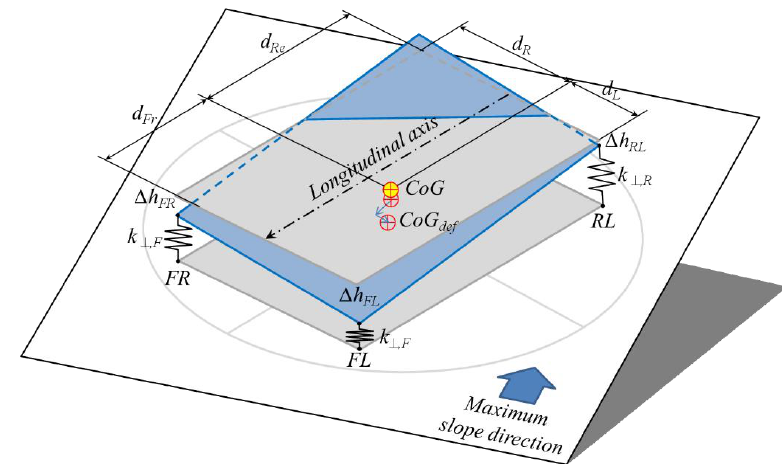
Figure 14. Graphical representation of the three-dimensional effect of a pure compression of the tyres due to the weight component in the direction perpendicular to the support plane, supported by each tyre. In the represented case, the FL tyre is the downstream tyre.